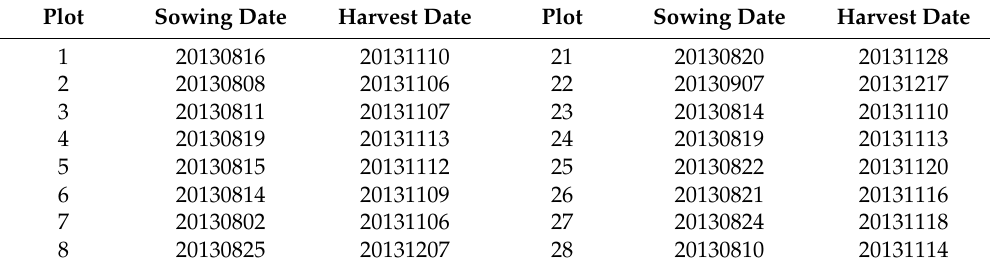
Table 3. Ground survey of the sowing date and harvest date (in yyyymmdd) of 40 rice field samples during the Autumn–Winter rice crop season 2013 in Chau Thanh and Thoai Son districts, An Giang province. Plot Sowing Date Harvest Date Plot Sowing Date Harvest